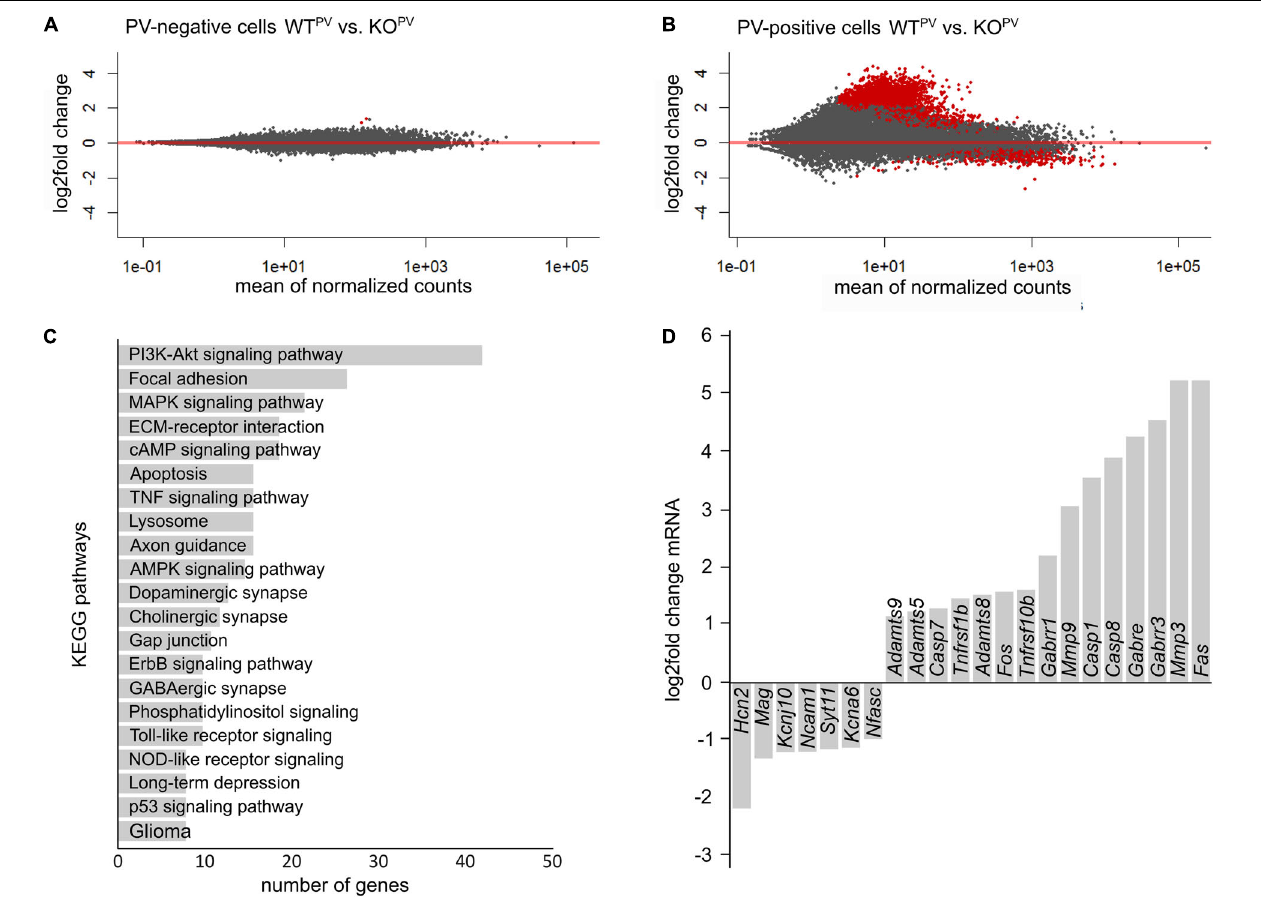
FIGURE 7 | Transcriptional profiling of PV-INs. (A,B) MA-plot illustrating differentially expressed genes in PV-negative (A) and PV-positive (B) cells isolated from 23-week-old WT PV and KCC2 KO PV mice ( n = 4/4 experiment; N = 8/8 mice (brains from 2 mice of the same genotype were pooled per experiment); red dots p < 0.05; Benjamini adjusted). (C) KEGG pathway enrichment analysis of 1,126 differentially expressed genes ( p < 0.05; Benjamini adjusted). (D) Selected differentially expressed genes in PV-INs of KCC2 KO PV mice.